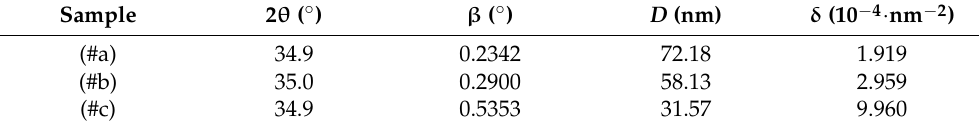
Table 3. Determination of the ZnO grain size and defect density by the use of the Debye–Scherrer